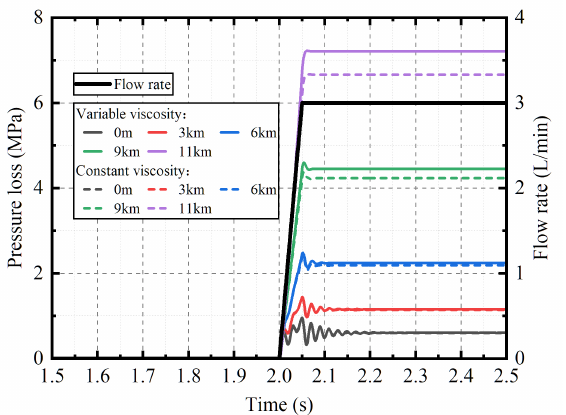
Figure 8. Comparison of pressure loss between pipelines with variable viscosity and constant viscosity at the same flow rate.